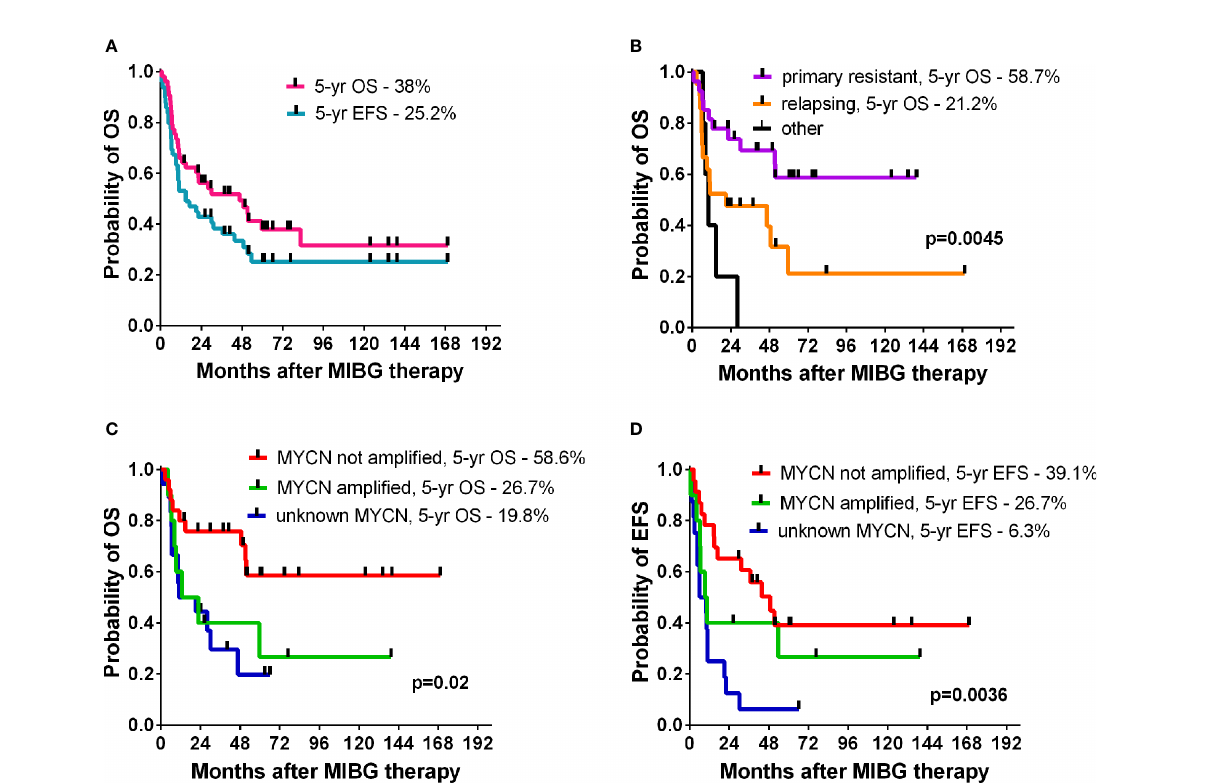
FIGURE 2 | The OS and EFS probabilities of patients treated with MIBG therapy (A) , OS in relapsing or resistant disease (B) , impact of MYCN status on OS (C) and EFS (D)